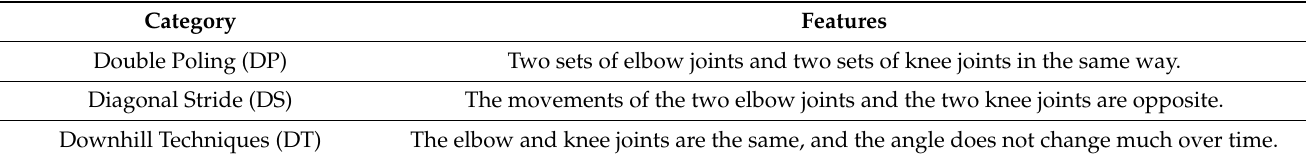
Table 1. The characteristics of the different cross-country skiing sub-actions. Category Features Double Poling (DP) Two sets of elbow joints and two sets of knee joints in the same way. Diagonal Stride (DS) The movements of the two elbow joints and the two knee joints are opposite. Downhill Techniques (DT) The elbow and knee joints are the same, and the angle does not change much over